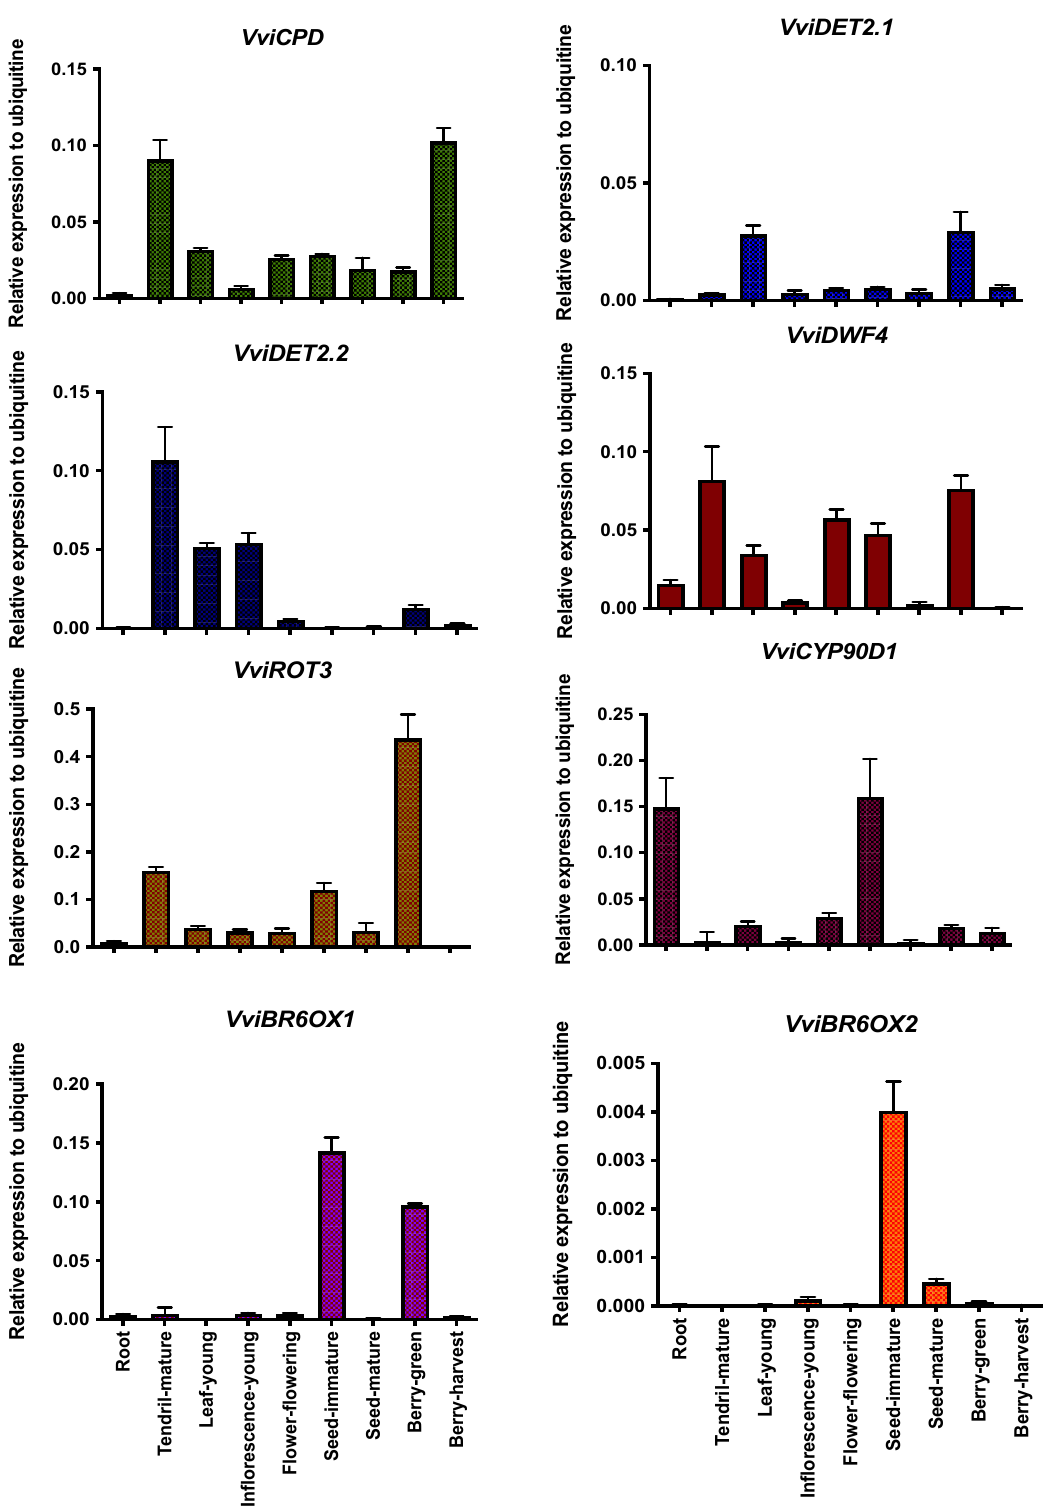
Figure 3. Expression levels of genes involved in brassinosteroid biosynthesis in cv. Cabernet sauvi- gnon grapevines. Expression data was normalized against the reference gene, VviUBI . Bars are the mean ± standard deviation of three biological and three technical replicates. Each biological replicate corresponds to a pool of tissue collected from five different plants.